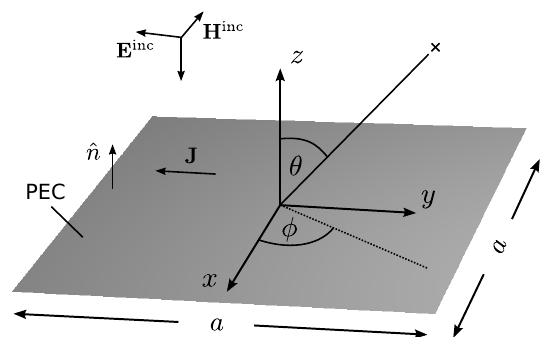
Figure 8: Radiation pattern in the upper hemisphere due to an monopole antenna placed on the ship surface. Compar- ison of proposed approach with conventional method. P : Maximum order of spherical harmonics. (cid:15) : Accuracy of compression with TSVD.